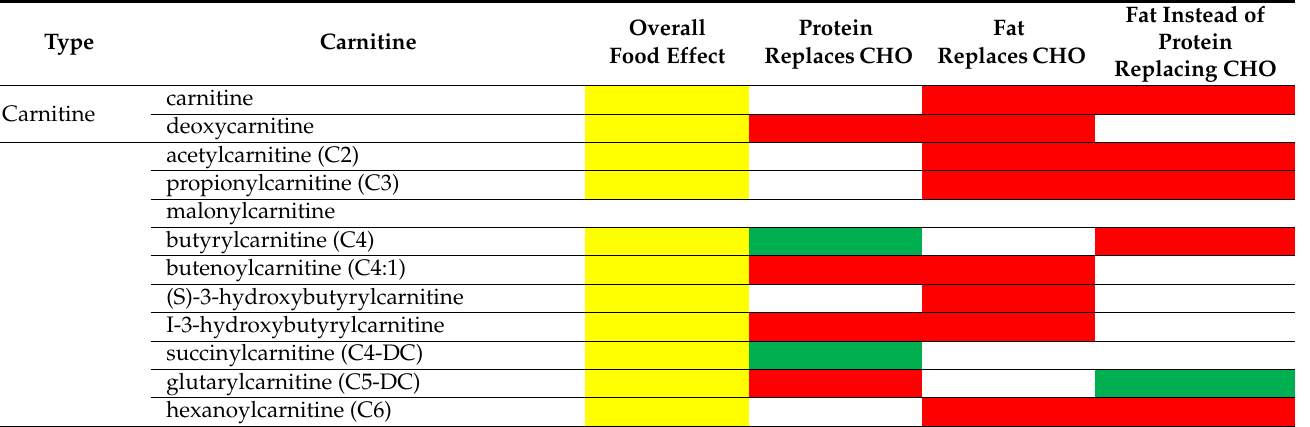
Table 10. Effects of foods on serum